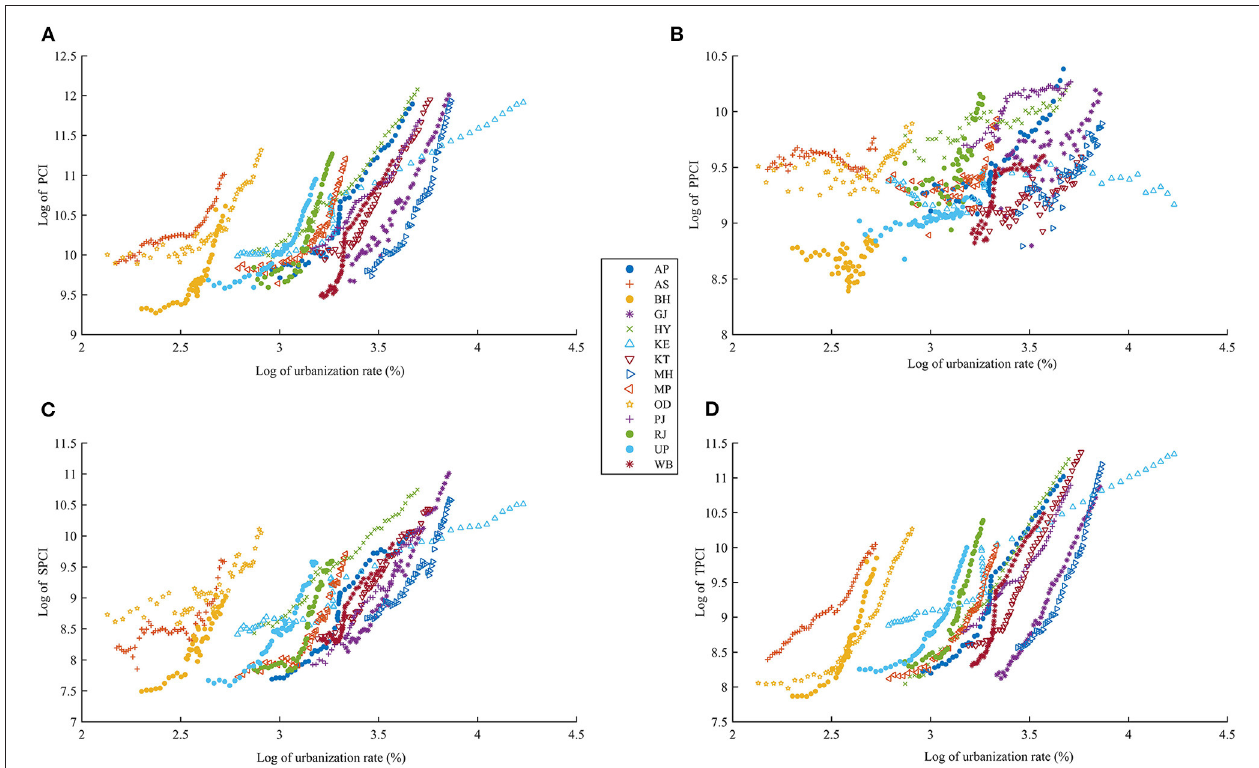
FIGURE 1 | Co-evolution of urbanization rate and total and sectoral per capita incomes among Indian states, 1971–2020. See Table 2 for abbreviations of the states. (A) Evolution of urbanization and per capita income in Indian states, 1971–2020. (B) Evolution of urbanization and primary sector per capita income in Indian states,